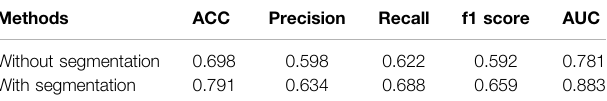
TABLE 2 | Classi fi cation results with or without